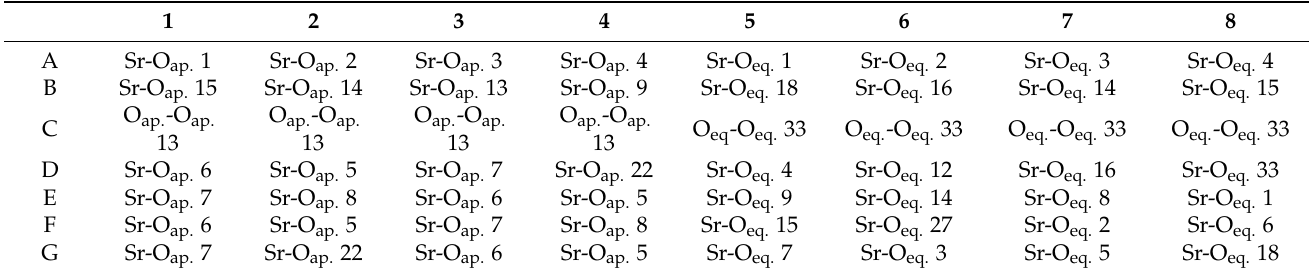
Table A10. Eight configurations -1-5, with the interatomic distances as in Table